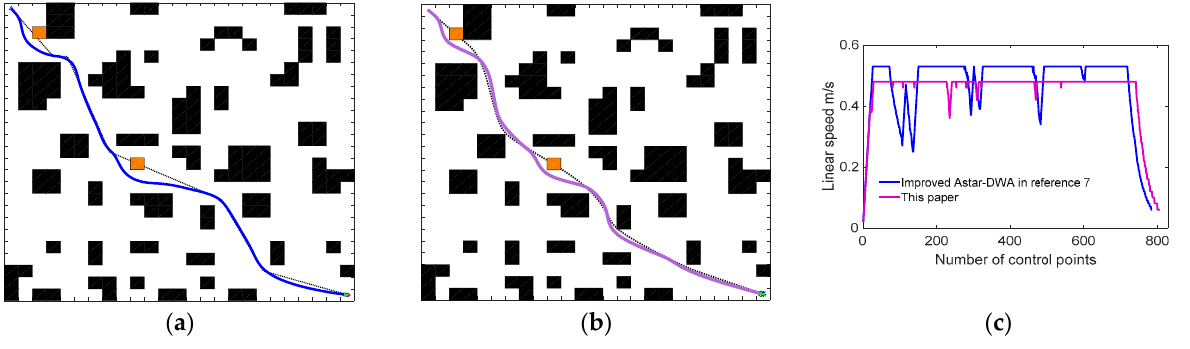
Figure 18. Comparison of path planning results for unknown static environment 1; ( a ) Local path planning [7] ( b ) This paper; and ( c ) Line speed comparison diagram.